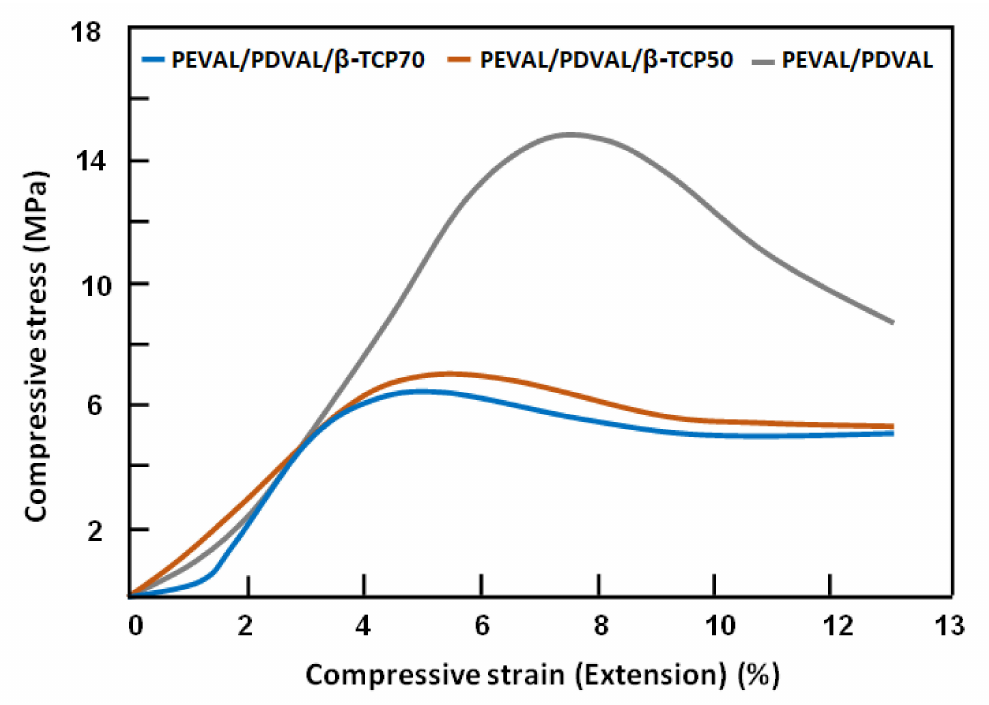
Figure 8. The stress-strain curves resulted from the compressive tests of the PEVAL/PDVAL/ β -TCP specimens with different β -TCP content and that of the virgin